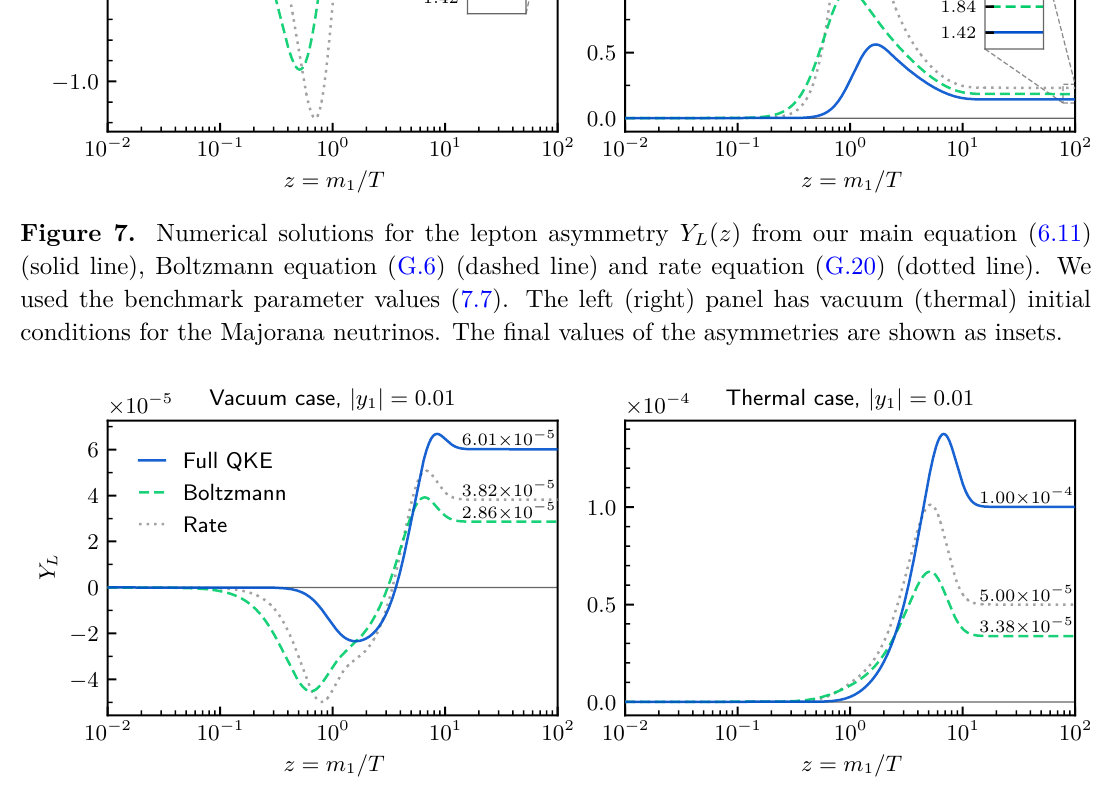
Figure 8. Numerical solutions for the lepton asymmetry Y L ( z ) , with the same setup and mass difference as figure 7 except | y 1 | = 0 . 01 . The final values of the asymmetries are indicated on the corresponding